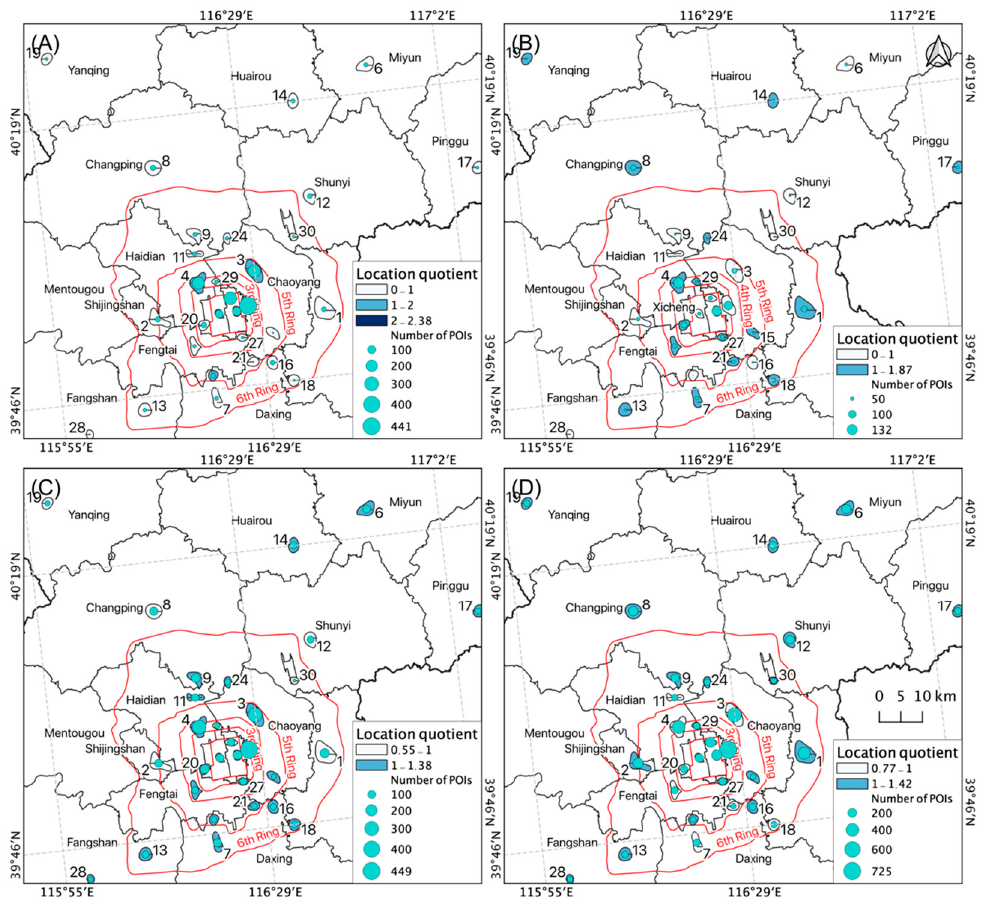
Figure 12. Location quotient distribution of ( A ) leisure catering, ( B ) commercial accommodation, ( C ) fast food businesses, and ( D ) restaurants within Beijing´s accommodation and catering industry cluster centers. Classification into low, relatively low, medium, relatively high, and high was made by the quantile (equal count) based on the calculation result of the location quotient (Table